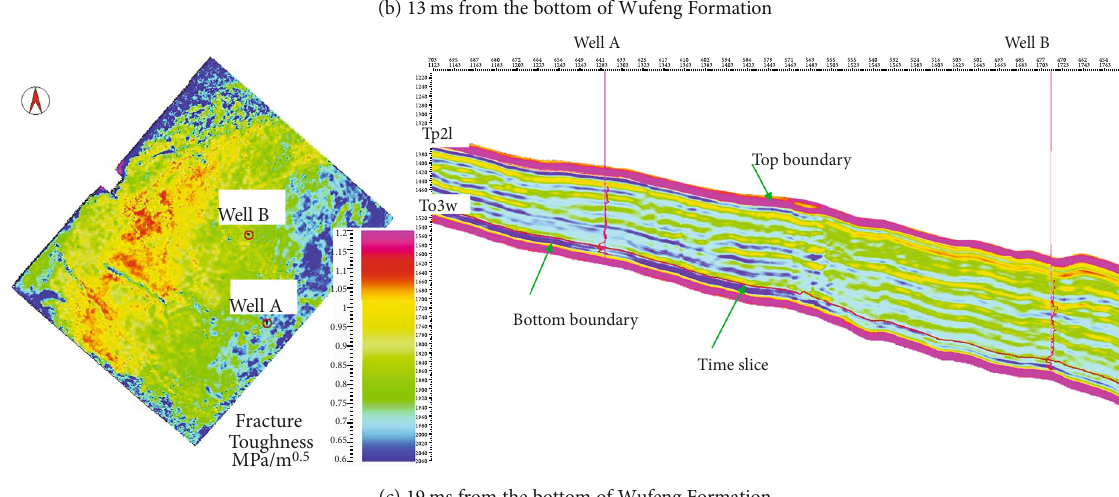
Figure 14: The plane distribution of the fracture toughness of shales in the bottom of Wufeng-Longmaxi